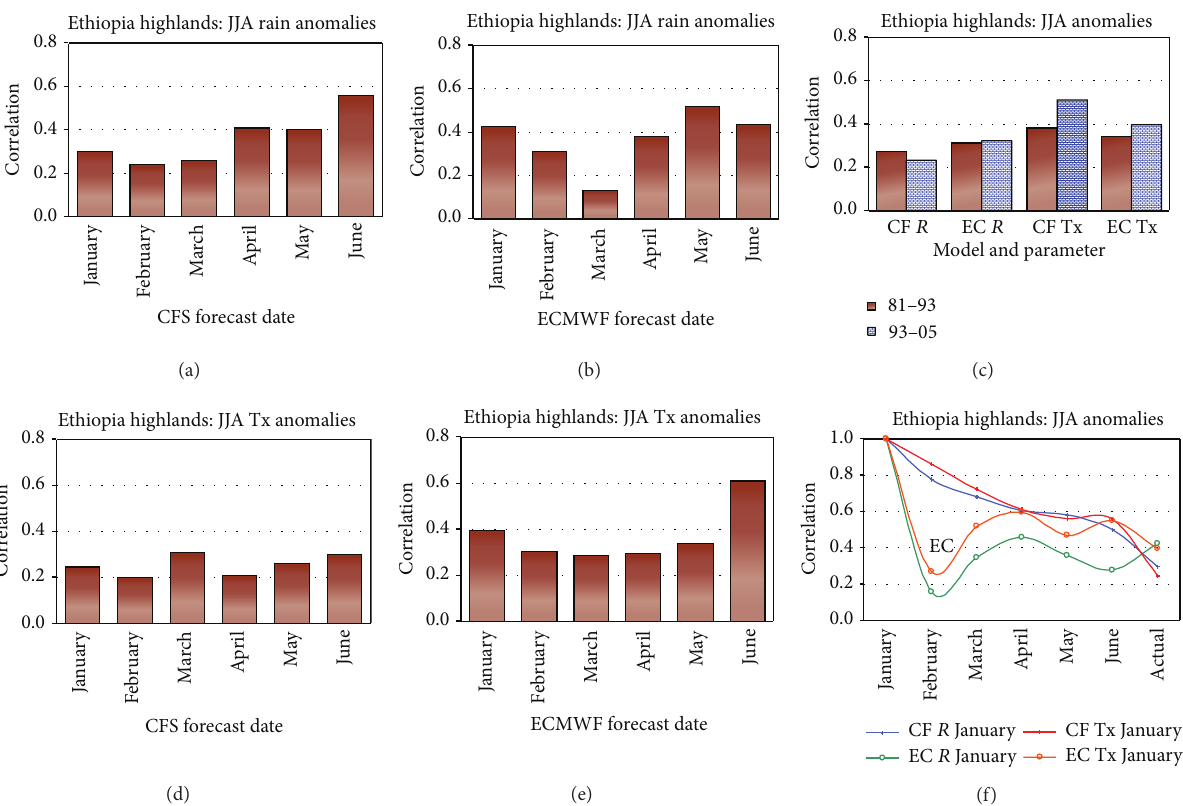
Figure 4: Bar charts summarizing model correlation with highlands area-averaged NMA-GPCC JJA rainfall (top) and CRU3 JJA maximum temperature (lower) for CFS ((a) and (d)) and ECMWF ((b) and (e)). (c) Model correlation in first and second half of sample. (f) Comparison of forecast persistence from January. Correlation values above 0.32 are significant at 90%